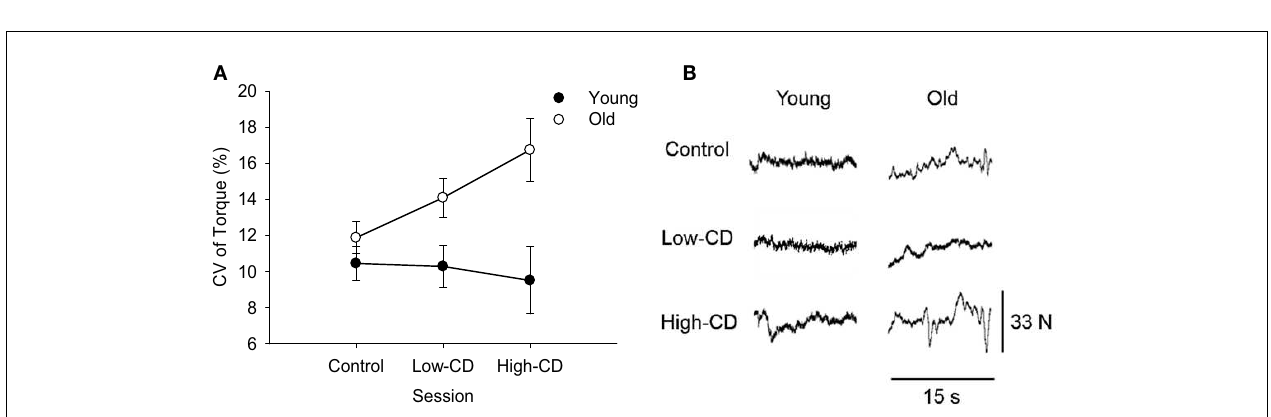
FIGURE 3 | Coefficient ofVariation (CV) of torque during the 5% MVC task for young (closed symbols) and older (open symbols) adults during the control, low-cognitive demand (Low-CD), and high-cognitive